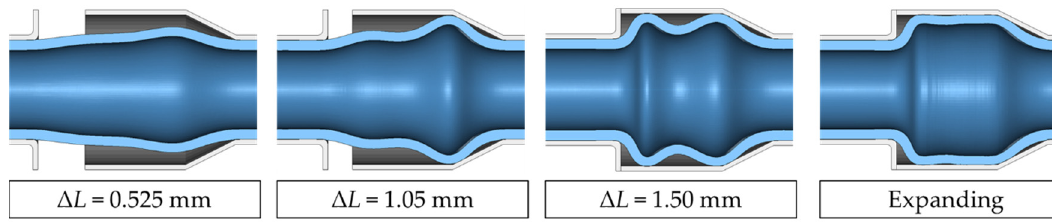
Figure 22. Deformation behavior of the small ZM21 tube in the cylinder-shape warm THF obtained by FEM at 250 °C using the modified loading path.